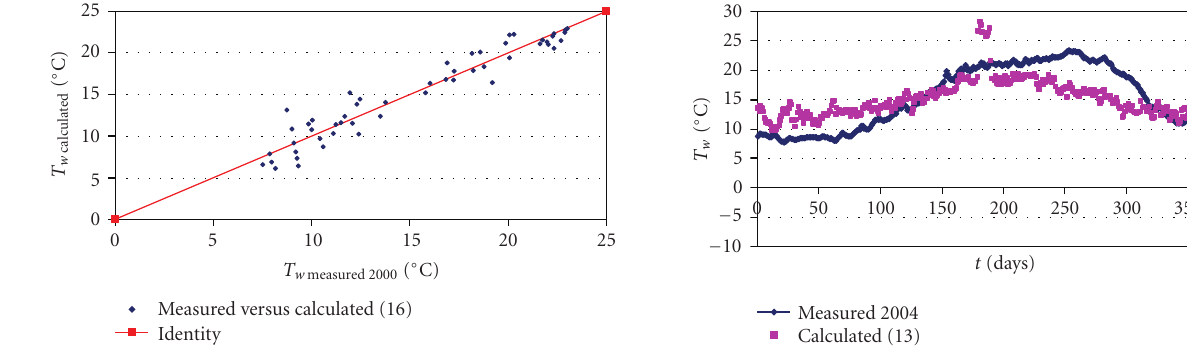
Figure 18: Measured and predicted water temperature for 2004, model with standardization (daily average values).